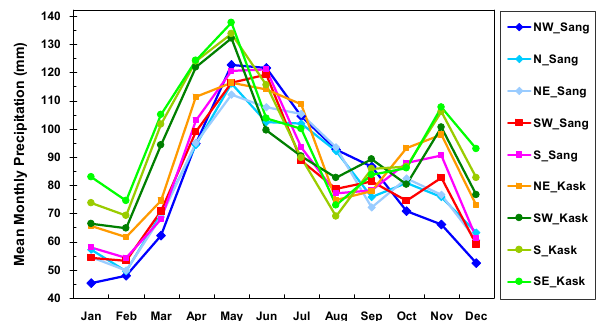
Fig. 7. Monthly precipitation regime curves for both watersheds for